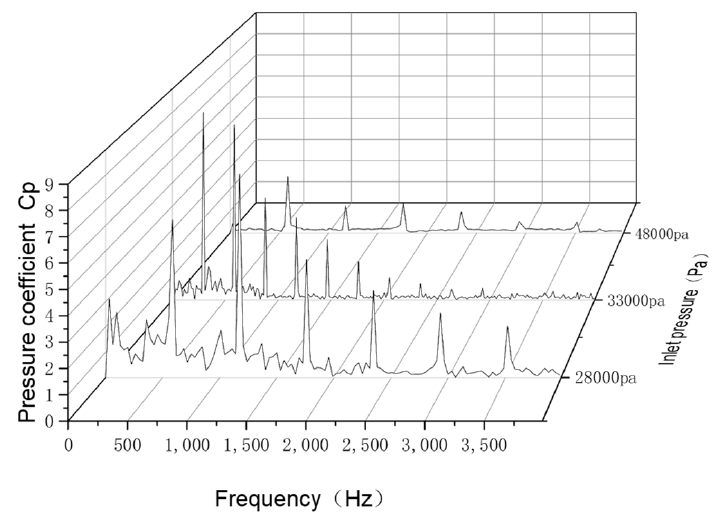
Figure 14. Frequency-domain diagram of pressure pulsation across the tongue.